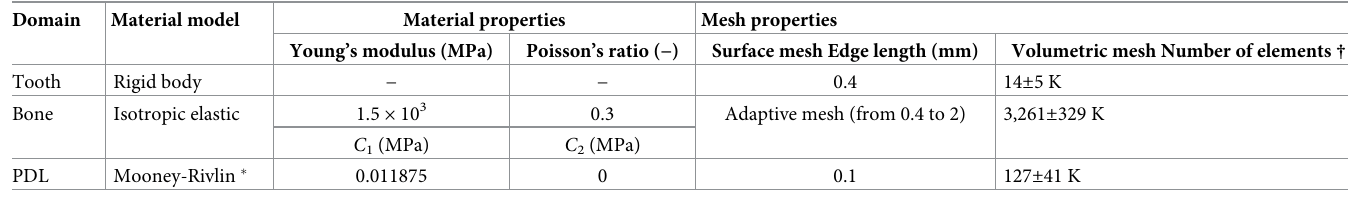
Table 2. Summary of the materials and mesh